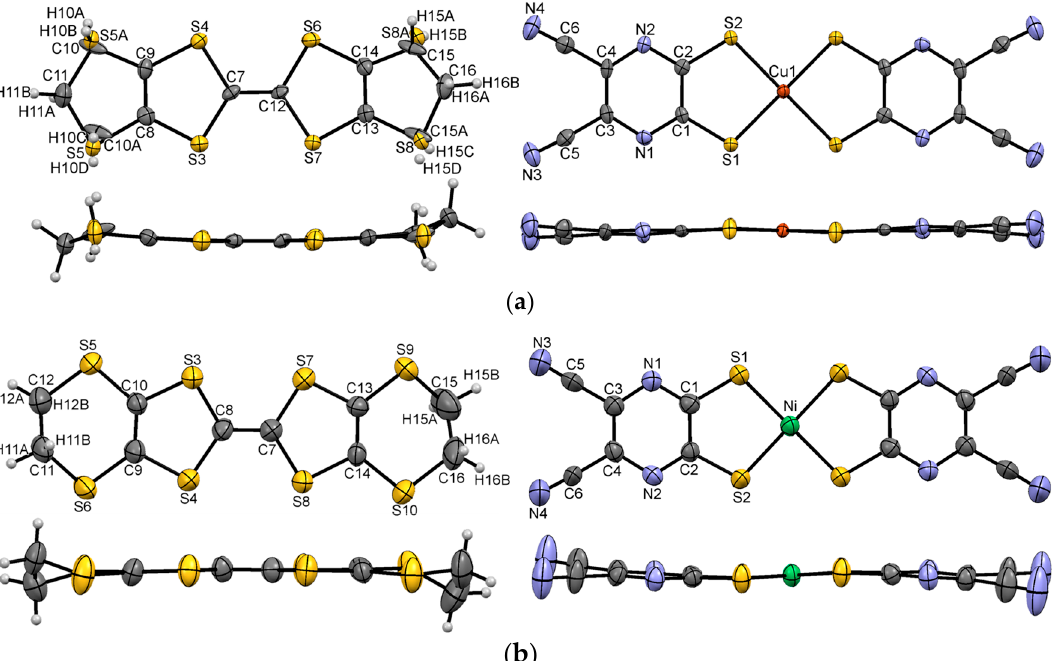
Figure 5. ORTEP and atomic numbering schemes (top and side views) of ( a ) BET-TTF donor molecule and acceptor [Cu(dcdmp) 2 ] in the crystal structure of (BET-TTF) 2 [Cu(dcdmp) 2 ] ( 5 ); and ( b ) ET donor molecules and acceptor [Ni(dcdmp) 2 ] in the crystal structure of (ET) 2 [Ni(dcdmp) 2 ] ( 6 ), with thermal ellipsoids drawn at 70% probability level.